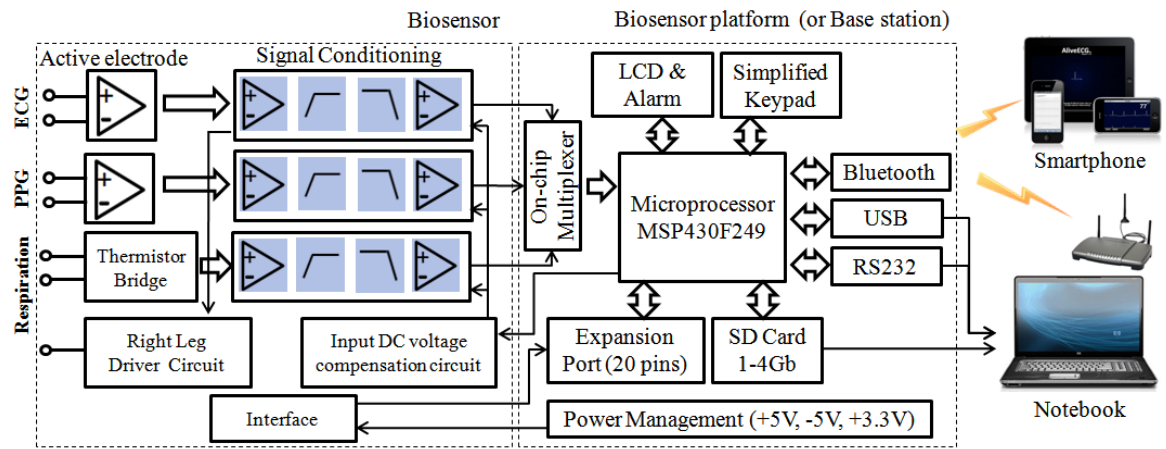
Figure 2. The hardware